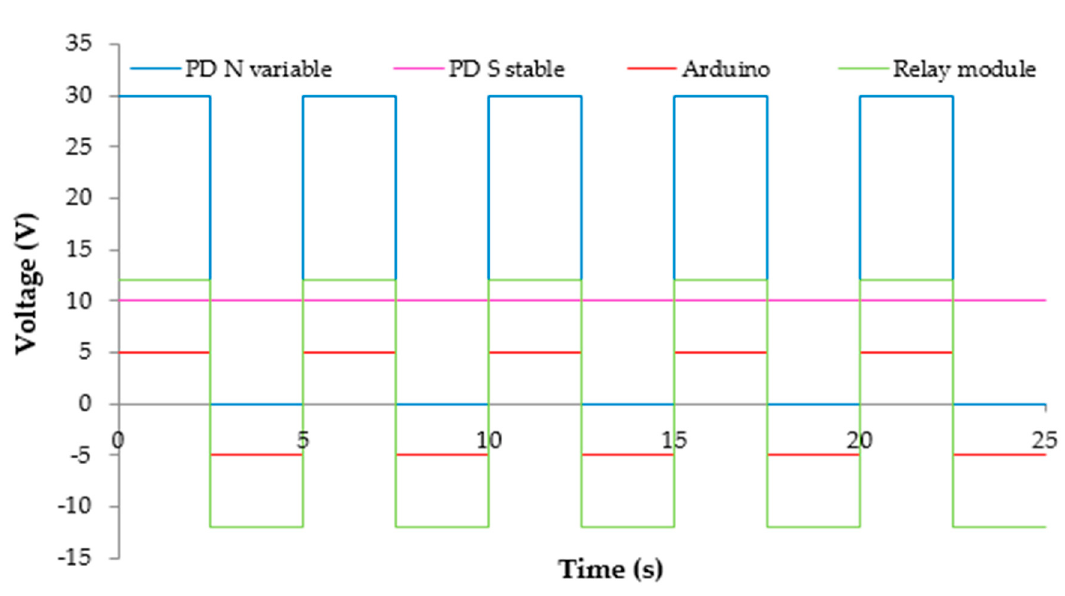
Figure 3. Response of the simulation of linear actuator performance.